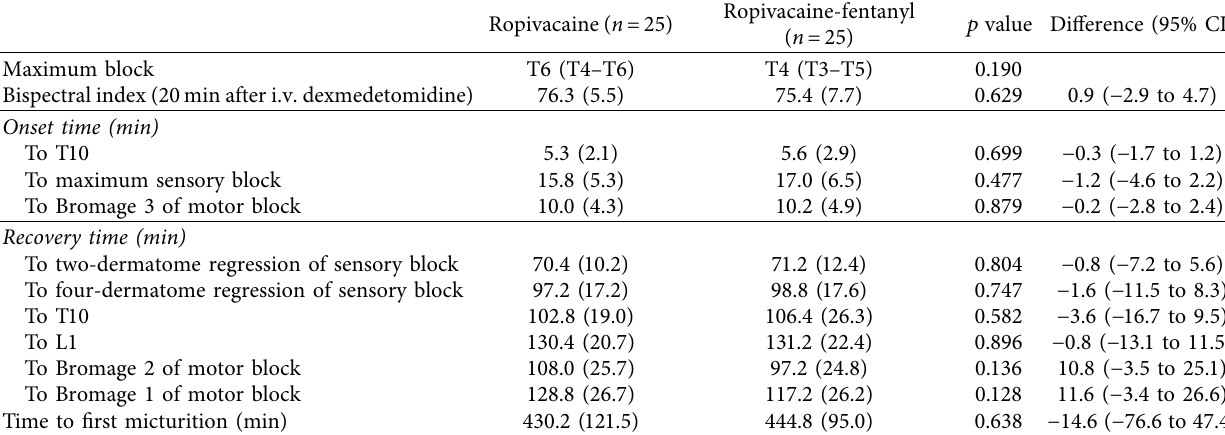
Table 2: Characteristics of the block.